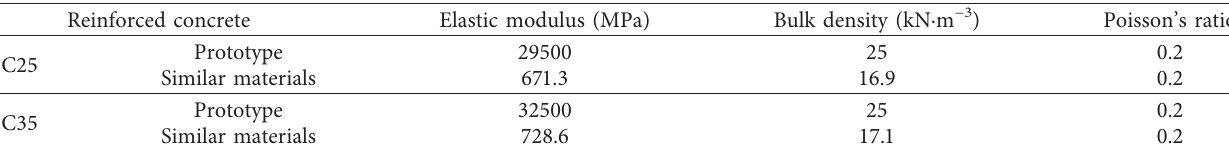
Figure 3: Secondary lining model. (a) Lining similar material mechanics test. (b) Lining model pouring. (c) Mold stripping. (d) Airing and lacquering. Table 3: The physical and mechanical parameters of lining model.